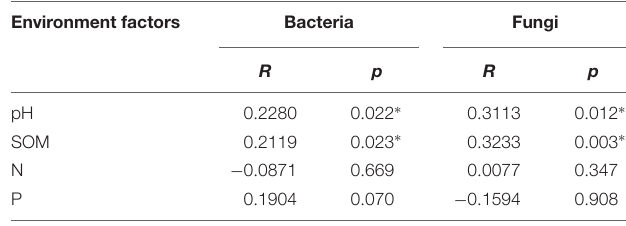
TABLE 3 | Correlation between microbial communities and environmental